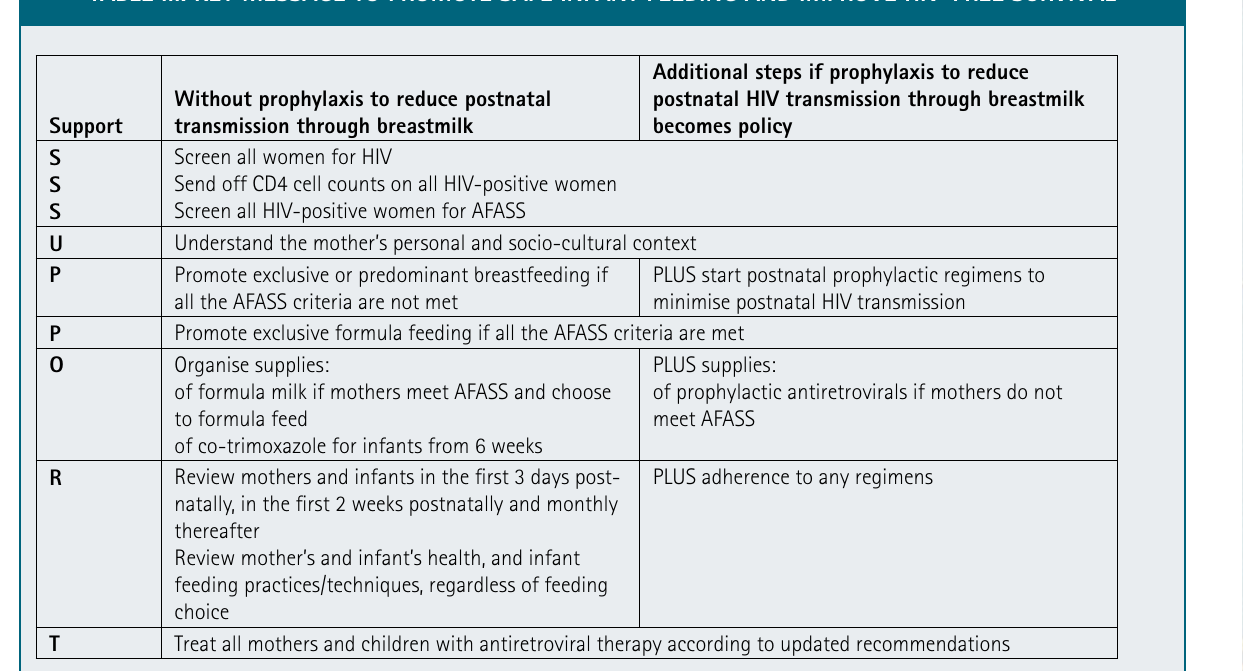
TABLE III. KEY MESSAGE TO PROMOTE SAFE INFANT FEEDING AND IMPROVE HIV-FREE